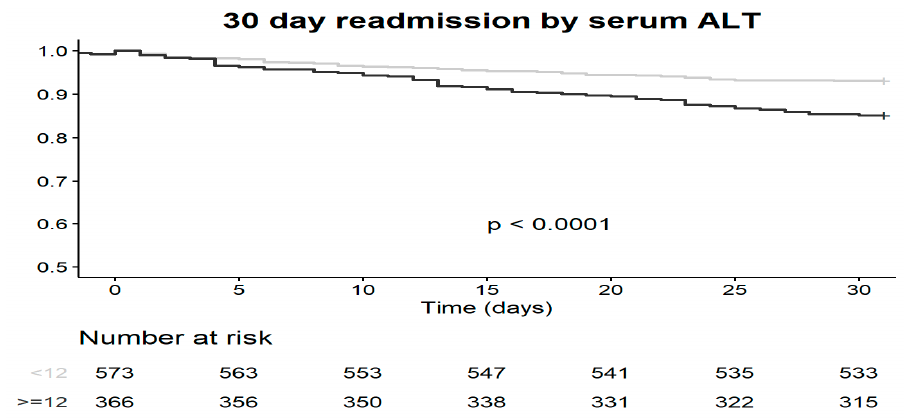
Figure 2. 30 days readmission according to FRAIL questionnaire classes.